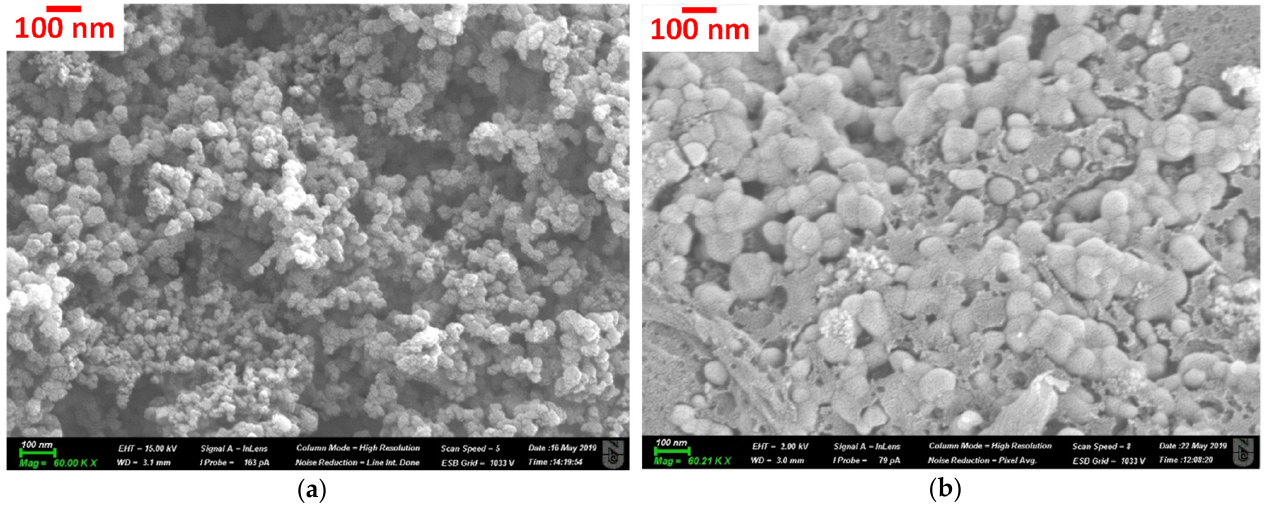
Figure 1. SEM images of RF_ac ( a ) and RMF-GO ( b ). The difference in the mesoscopic morphological 3D structures of the two carbon materials is obvious. The melamine and graphene oxide additives result in a more compact pore structure. This is also reflected in their N 2 adsorption/desorption isotherms (Figure 2) and the data deduced from the isotherms, shown in Table 2.